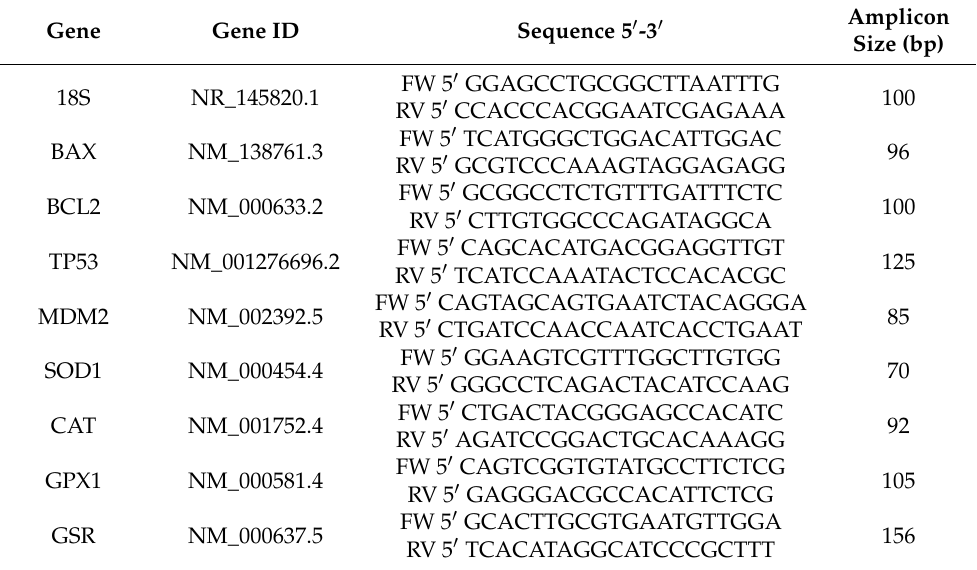
Table 1. Primer sequences and amplicon size used for gene expression analysis by real-time